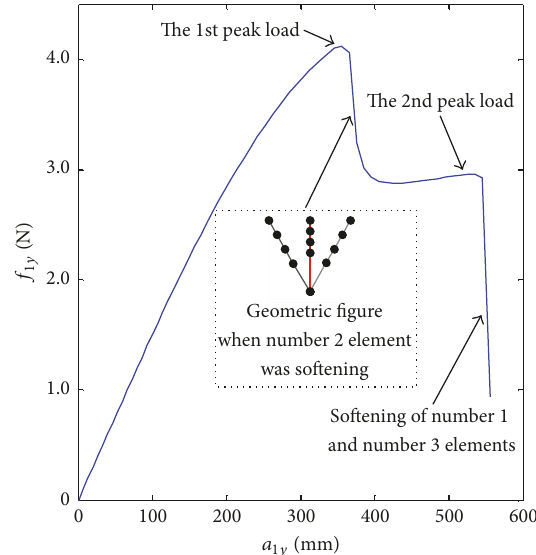
Figure 3: Load-deflection curve of node 1 in 𝑦 direction of Model I.